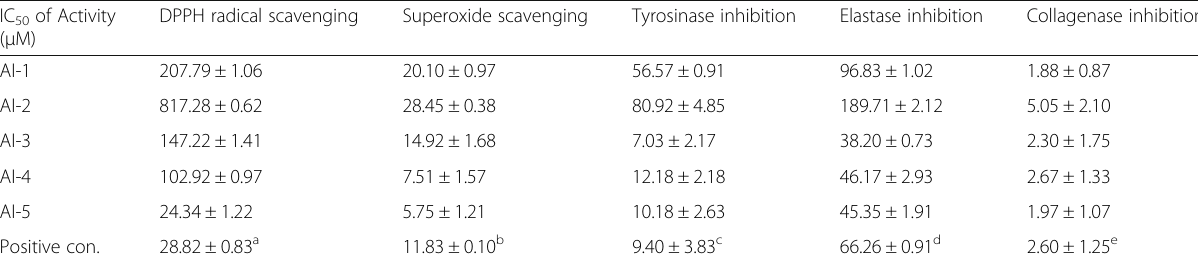
Table 6 IC 50 values for activity by compounds from Artemisia iwayomogi IC 50 of Activity ( μ M)